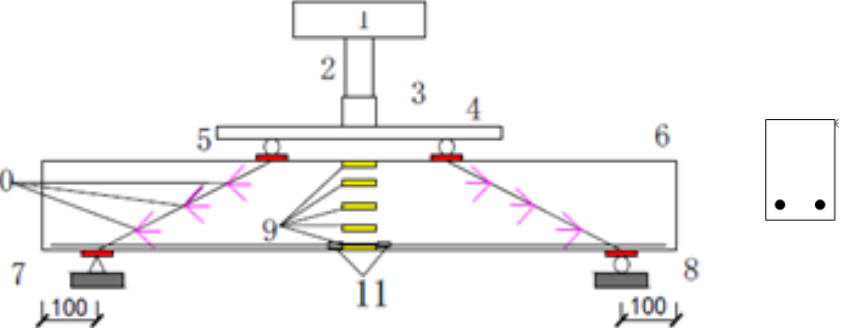
Figure 3. The layout of measuring points: 1 Reaction Frame, 2 Lifting Jack, 3 force sensor, 4 distribu- tive girder, 5 Cushion block, 6 Test-piece, 7 pin support, 8 roller support, 9 Midspan concrete foil strain gauge, 10 Concrete foil strain rosette at shear span, 11 Longitudinal bar foil strain gauge. By static loading, the final failure modes of these four recycled concrete beams are shown in Figure 4. The main data obtained from the experiment are listed in Tables 6 and 7, respectively. In Table 7, the shear fracture strength and shear strength are the ratio of P cr to b × h and P u to b ×